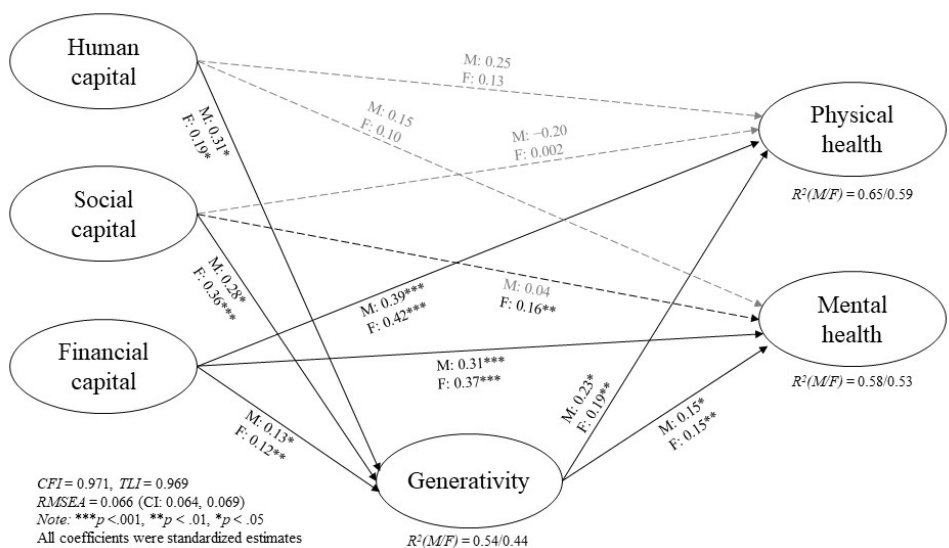
Figure 2. Gender variations in the effects of human, social, and financial capital on physical and mental health, mediated by generativity. Covariates were controlled for age, marital status, working status, income, assets, and asset ownership. Structural standardized estimates were reported from the final structural models. Black solid lines refer to statistically significant paths; black dashed line refers to gender-specific significant paths; gray dashed lines refer to nonsignificant paths. *** p < 0.001, ** p < 0.01, * p < 0.05.